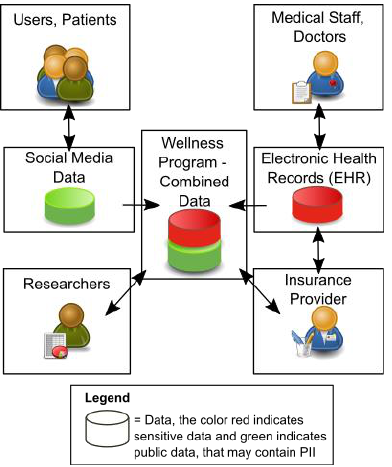
Figure 4. A multi-tenant, multi- level “wellness program” use -case for analyzing BDP security.